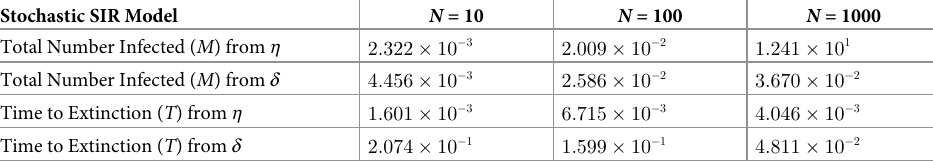
Table 9. Prediction error results for the stochastic SIR model. Derivatives are calculated with the complex perturba- tion. All predictions are for a 10% change in parameter. Parameters match those previously introduced in